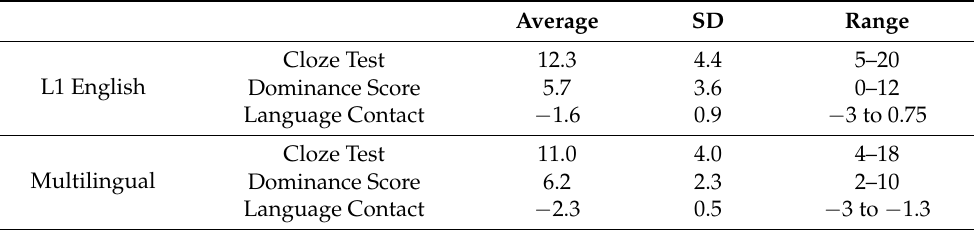
Table 3. Learner cloze test, language dominance, and language contact scores for the AJT.